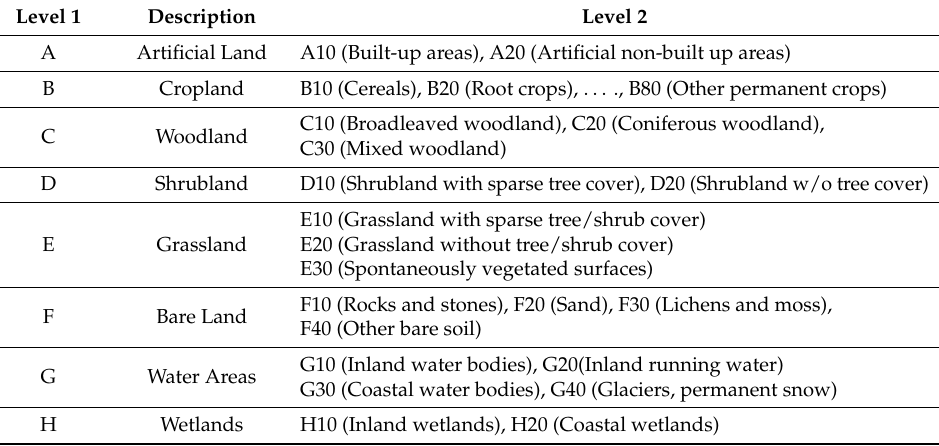
Table 1. LUCAS (Land Use Cover Area frame Sample) land cover classification